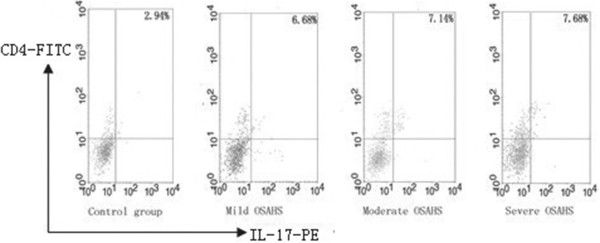
The percentage of CD4+IL-17+ cells. Single-cell suspensions prepared from the peripheral blood of 17 patients were double-stained with FITC-conjugated anti-CD4 and PE-conjugated anti-IL-17 and were analysed by flow cytometry.